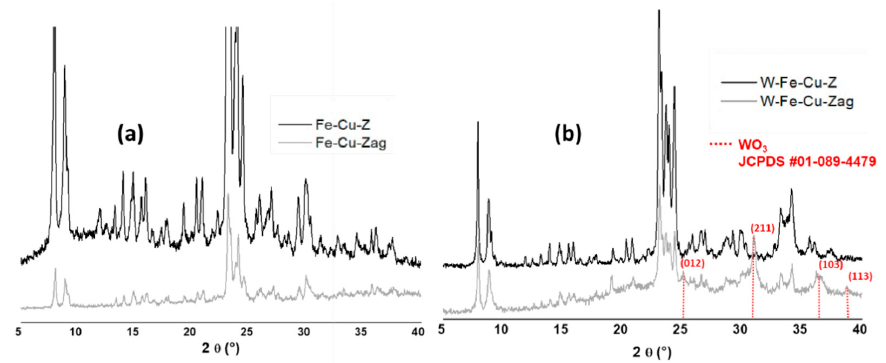
Figure 2. XRD diffractograms of fresh and aged ( a ) Fe-Cu-Z and ( b ) W-Fe-Cu-Z catalysts. XRD pattern of Fe-Cu-Zag showed a decrease in the peaks intensity with the absence